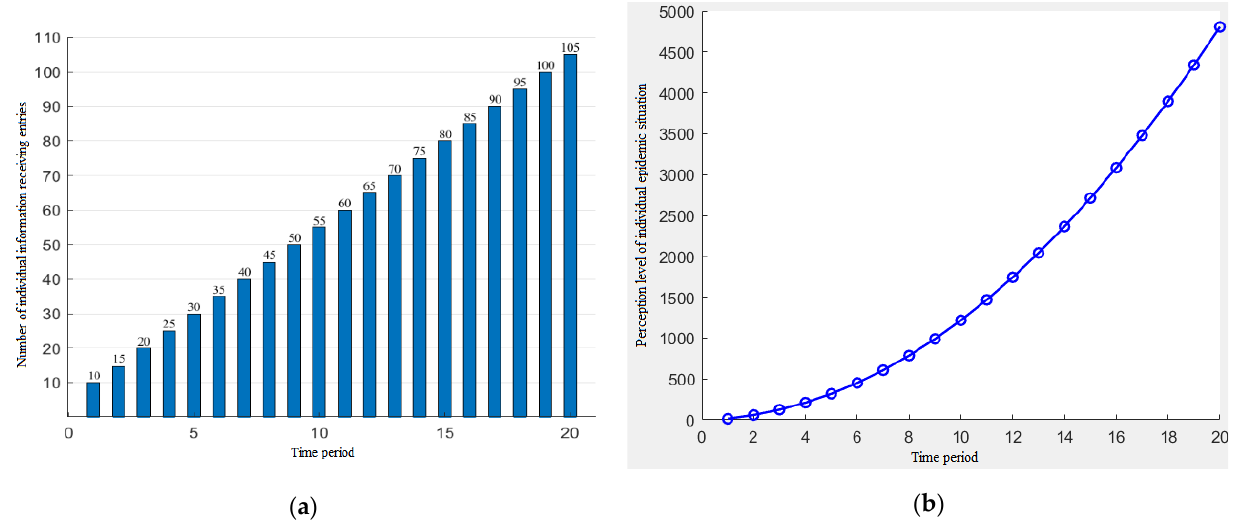
Figure 3. The increasing trend of the individual information reception ( a ) and the change of the individual perception level ( b ).